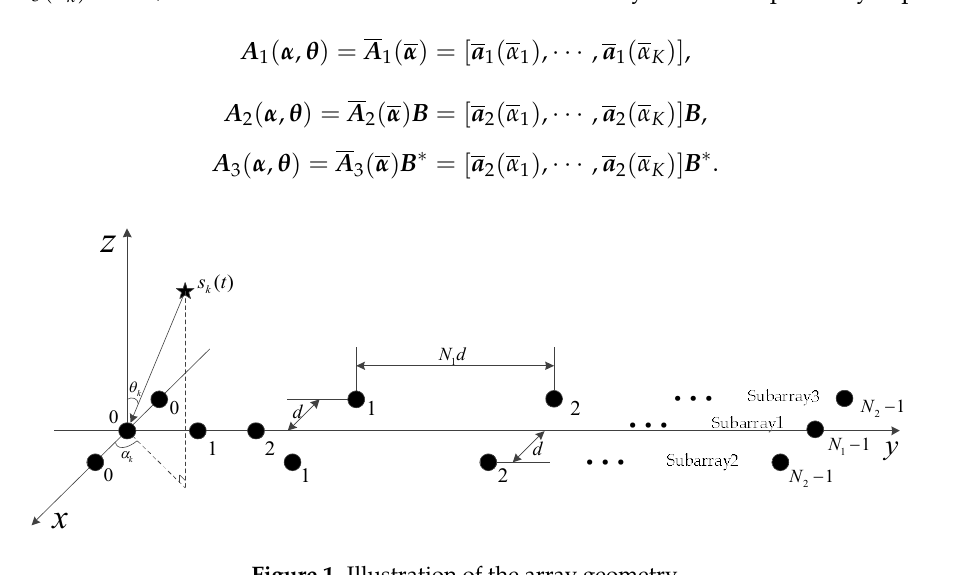
Figure 1. Illustration of the array geometry.